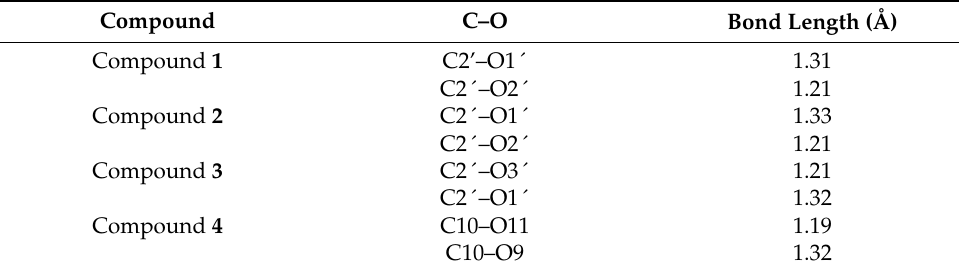
Table 4. C–O bond lengths of the carboxylic acid moieties of compounds 1 – 4